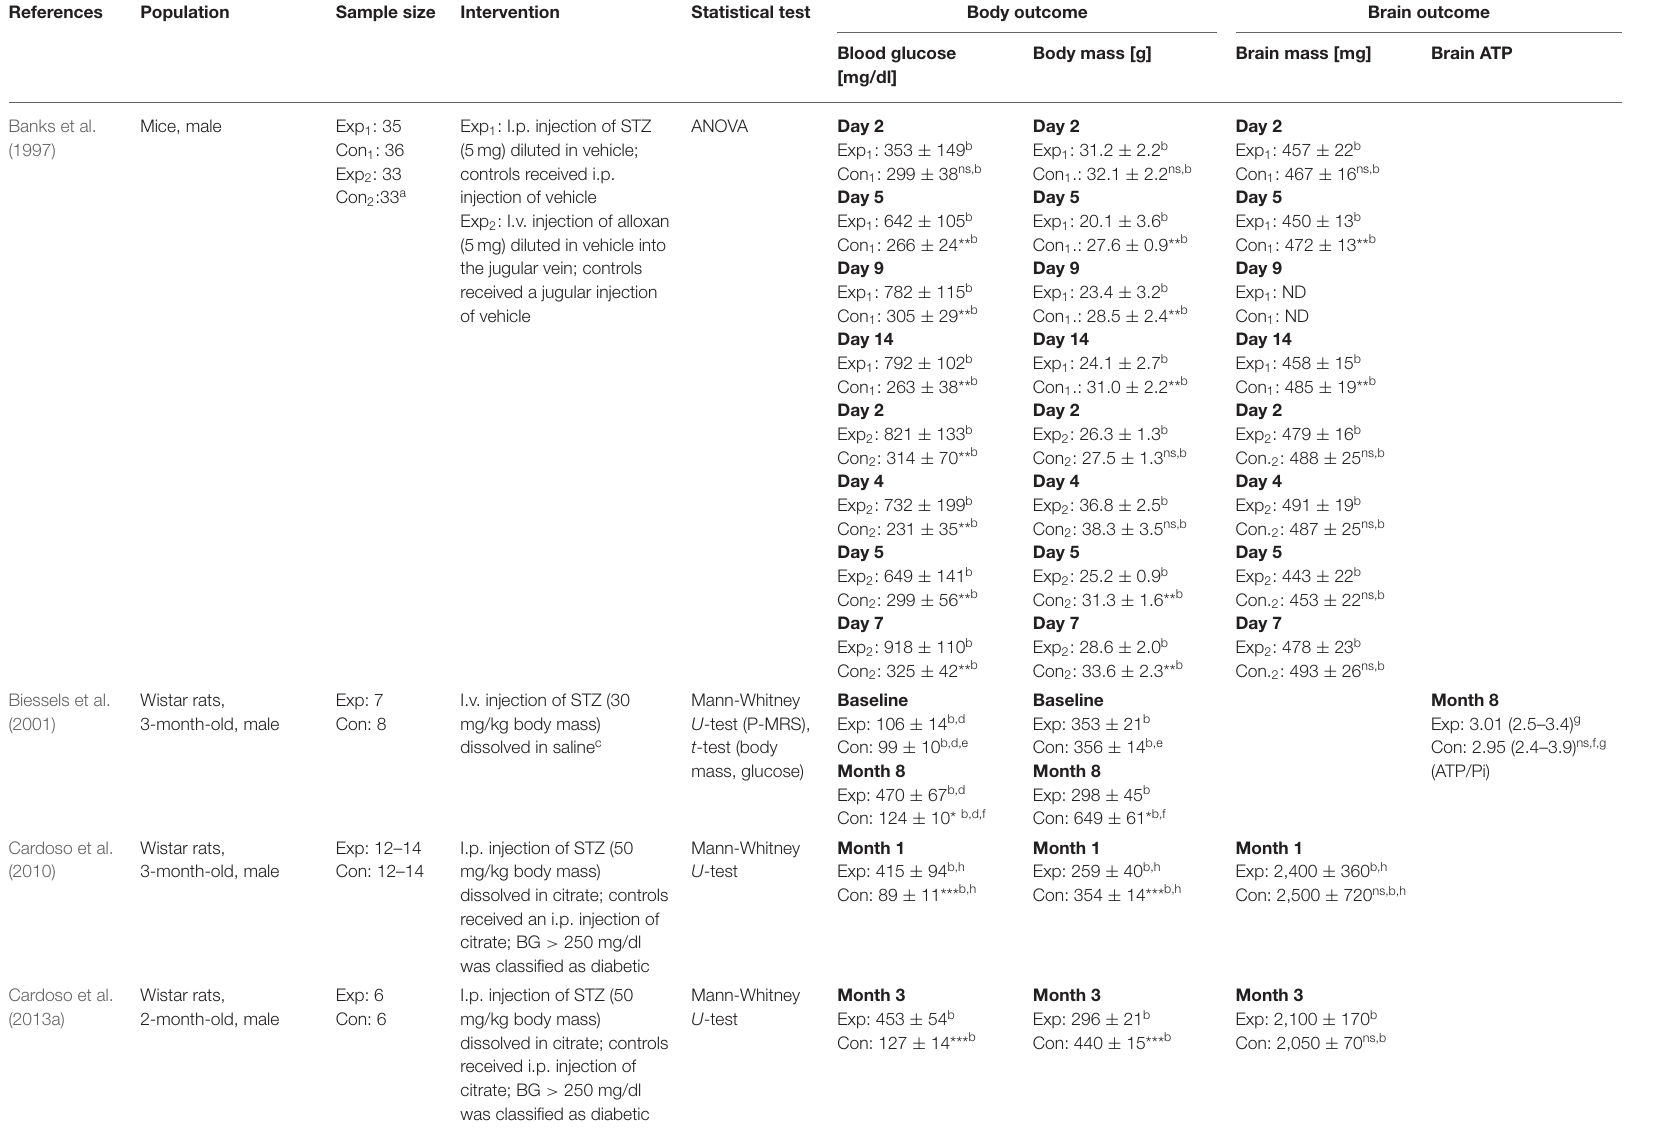
TABLE 1 | Characteristics and results of included